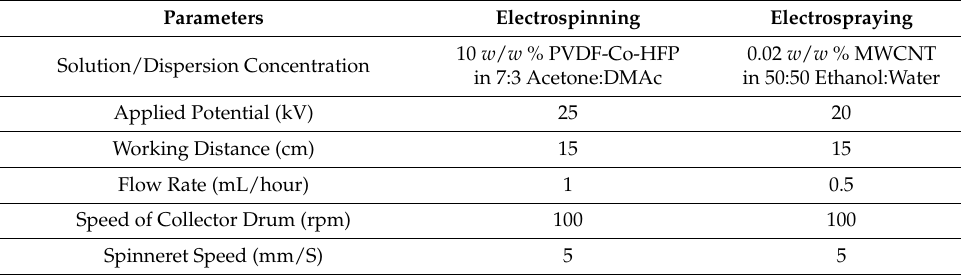
Table 1. Electrospinning and electrospraying